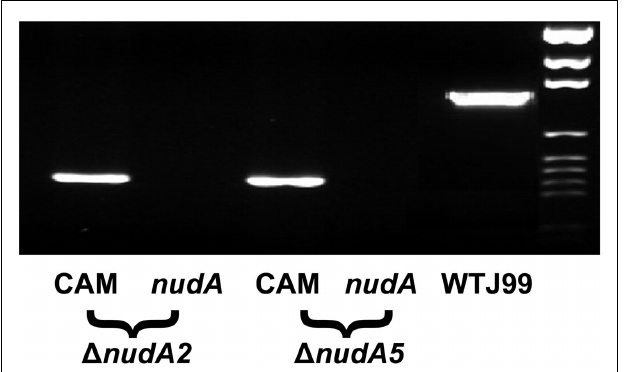
FIGURE 1 |Verification of post-transformation bacterial DNA in the Δ nudA allele PCR products on agarose gel. Two pairs of primers were designed for verification of post-transformation of bacterial transformed with Δ nudA allele PCR products. One pair was specific for nudA and the other pair was specific for the CamR gene.The wild type strain J99 PCR product was used as positive control.The figure illustrates that the nudA gene was present only in wild type strain J99 but absent in nudA mutant strains while the CamR gene was present in nudA mutant strains but not in the wild